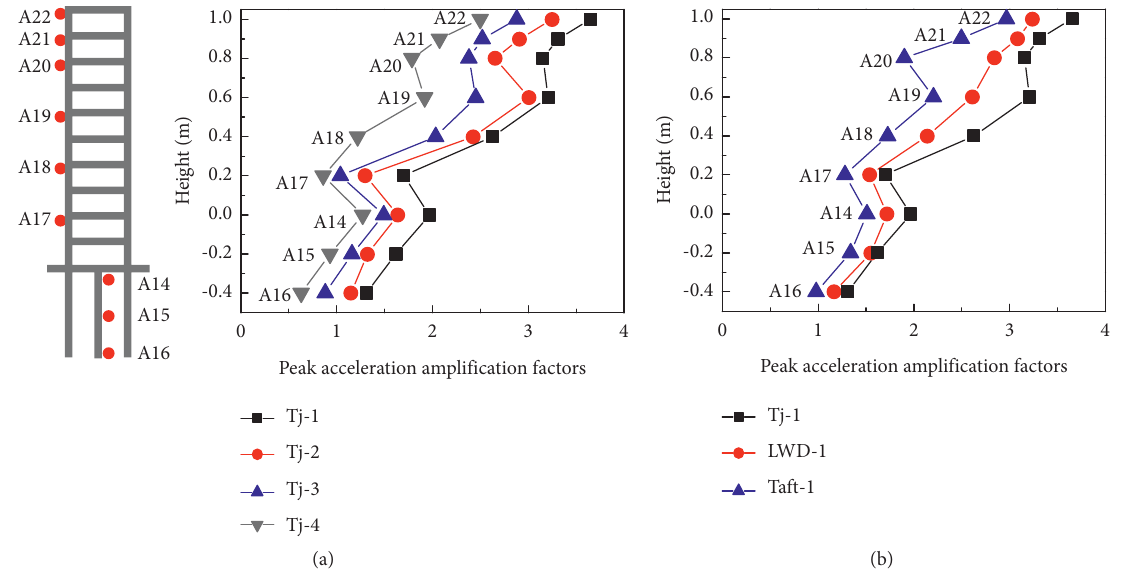
Figure 12: Peak acceleration of the surface structure-pile system with height. (a) System under Tianjin wave. (b) System under different seismic